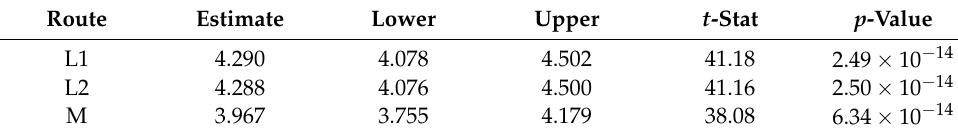
Table 3. The results of GLMM on log transformed UFP concentration.